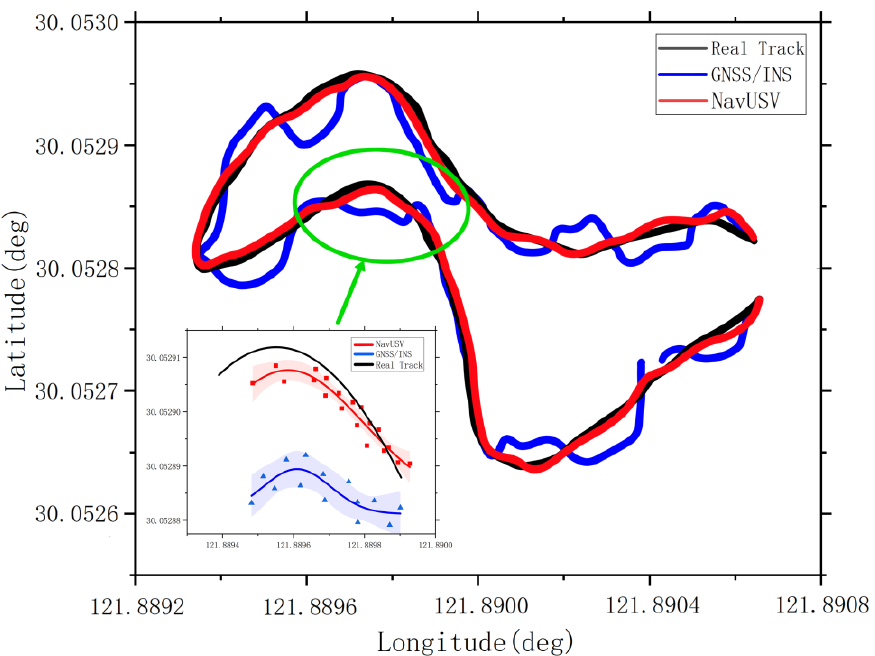
Figure 11. Comparison of tracks by using INS and NavUSV integrated navigation.